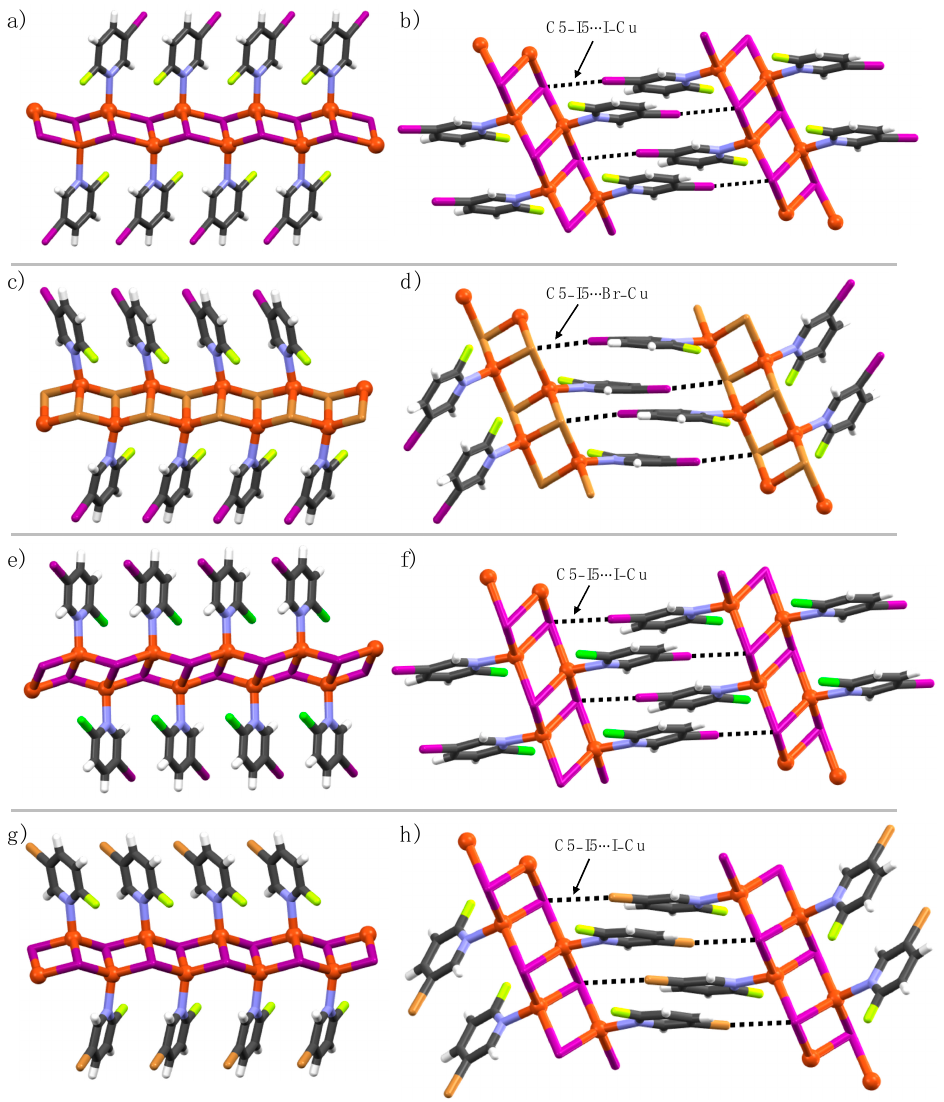
Figure 2. 1-D Polymeric view of ( a ) 1a , ( b ) 1b , ( c ) 2a , and ( d ) 5a , and ( e – h ) their respective section of crystal packing structures displaying halogen bonding interactions (black dotted lines).